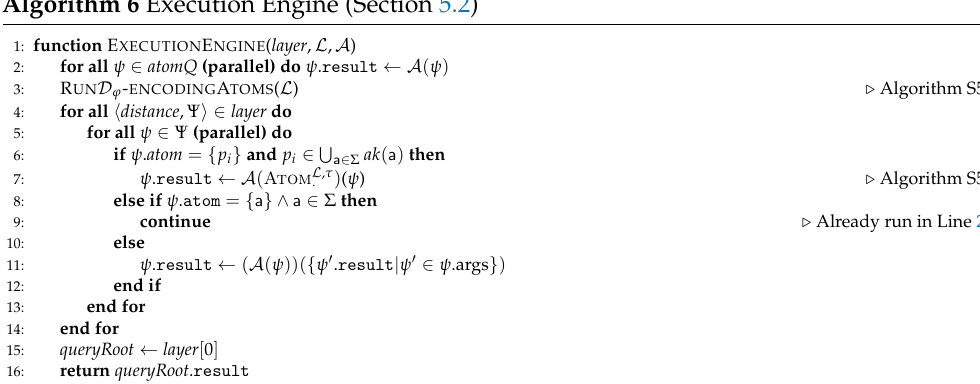
Algorithm 6 Execution Engine (Section